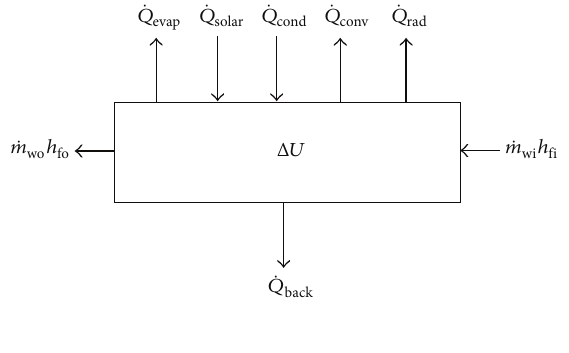
Figure 3: Water pond energy